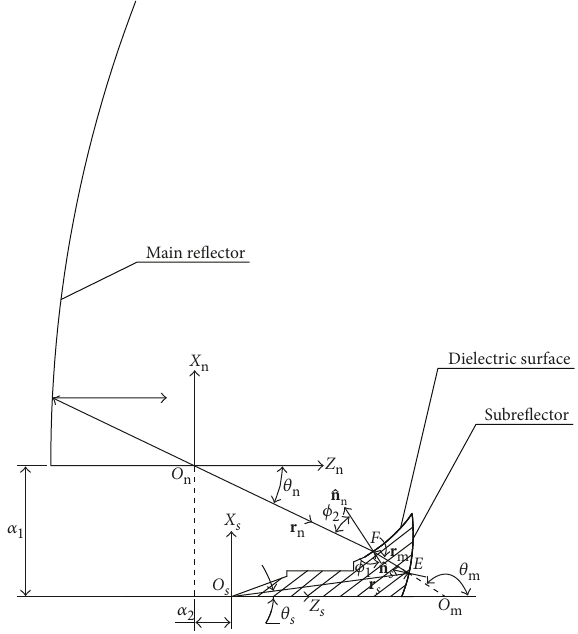
Figure 1: Principle of ring-focus antenna with splash plate